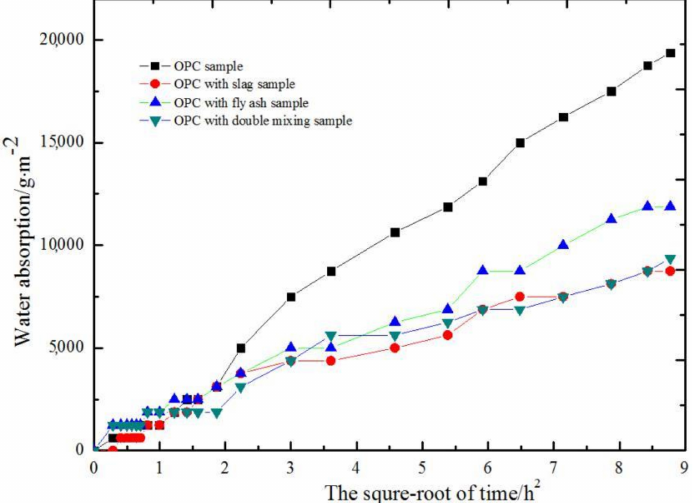
Figure 3. Relationship between water absorption and square root of time (28 days cured